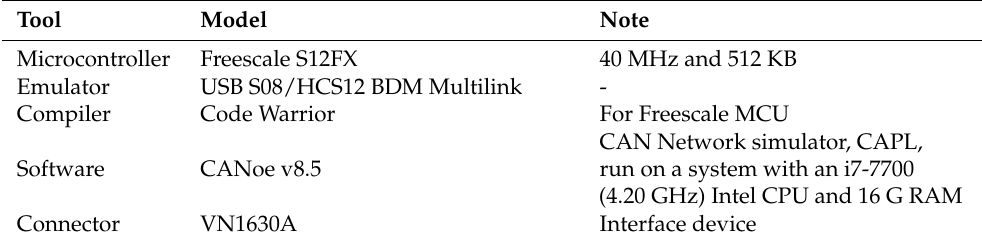
Table 4. Specification of hardware and software used in our